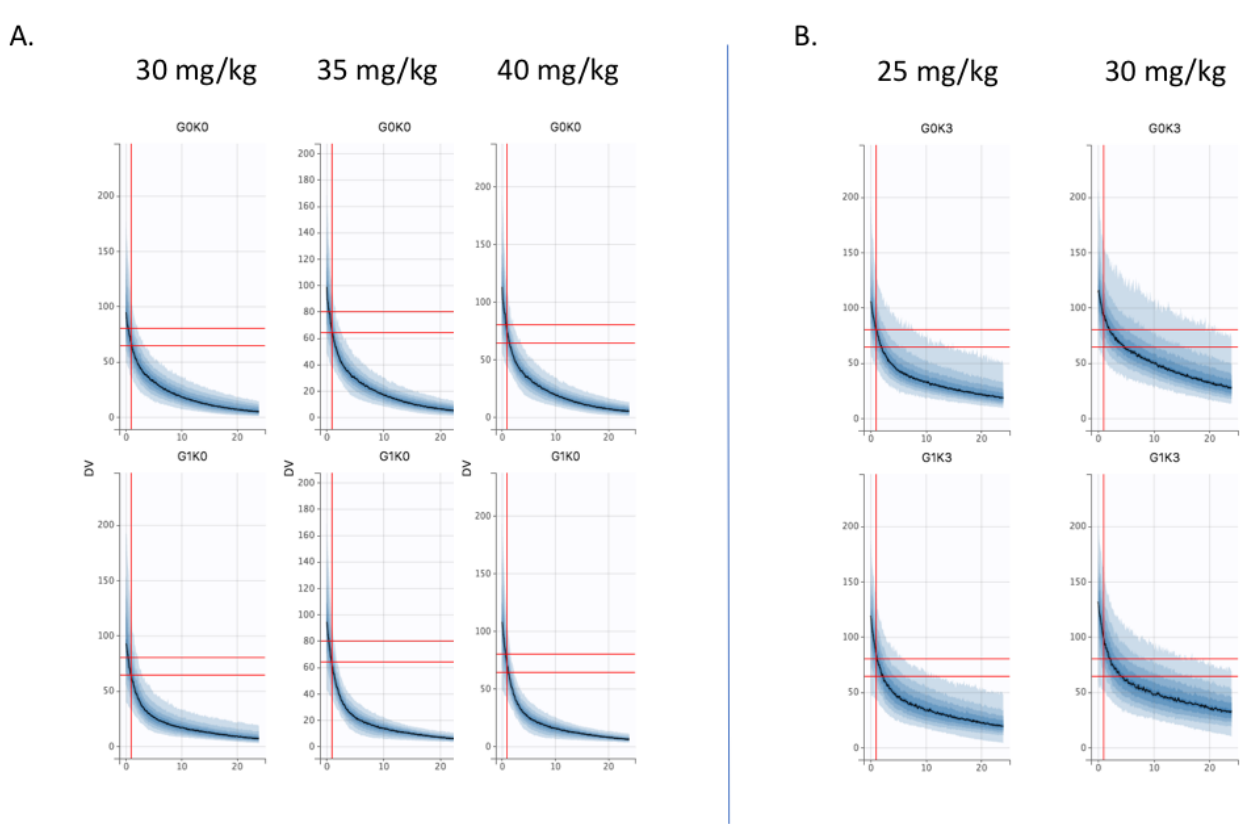
Figure 4. Dose simulations ( A ) at 35 mg/kg and 40 mg/kg in KDIGO stage 0 control (G0K0, top) and V-A ECMO (G1K0, bottom) patients vs. 30 mg/kg ( B ) at 25 mg/kg in KDIGO stage 3 control (G0K0, top) and V-A ECMO (G3K0, bottom) patients vs. 30